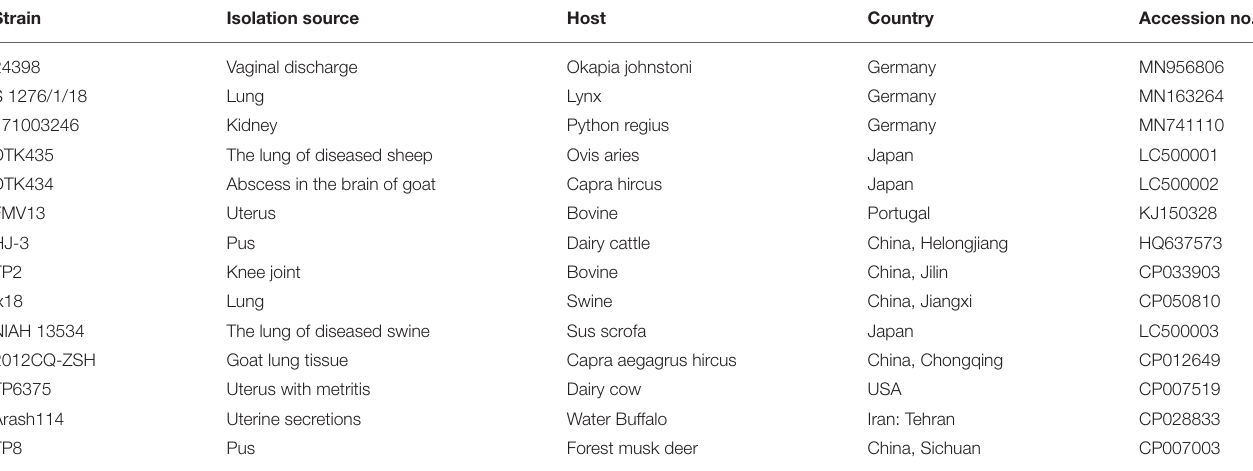
TABLE 3 | Trueperella pyogenes pyolysin genes referenced in this study.